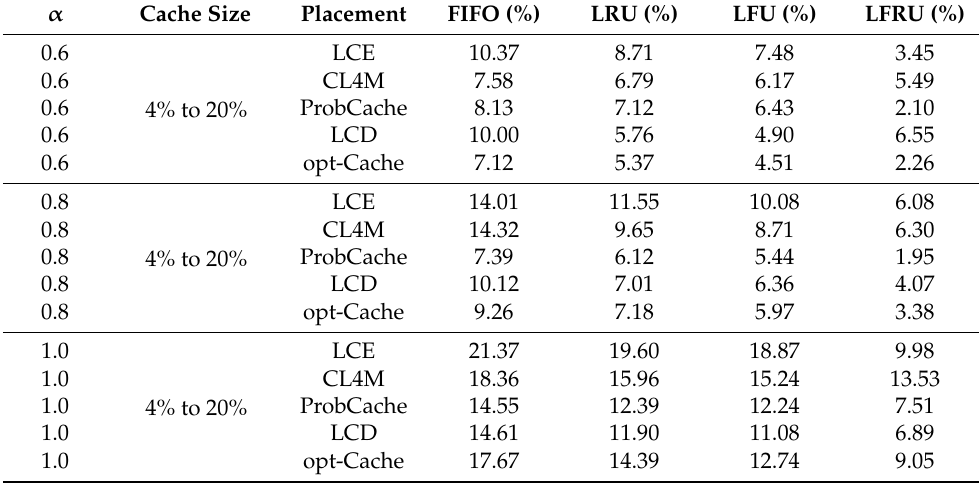
Table 12. IMU latency percentage